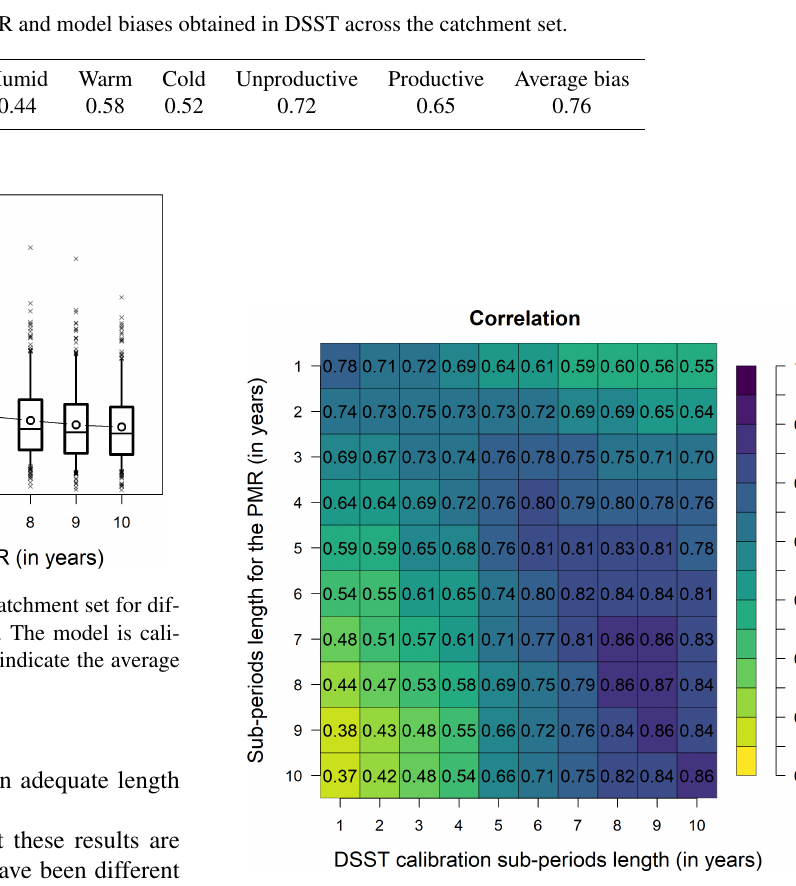
Figure 7. Pearson’s correlation between the PMR computed on varying sub-period lengths (vertical axis) and the average DSST biases obtained on varying sub-period lengths for calibration and evaluation (horizontal